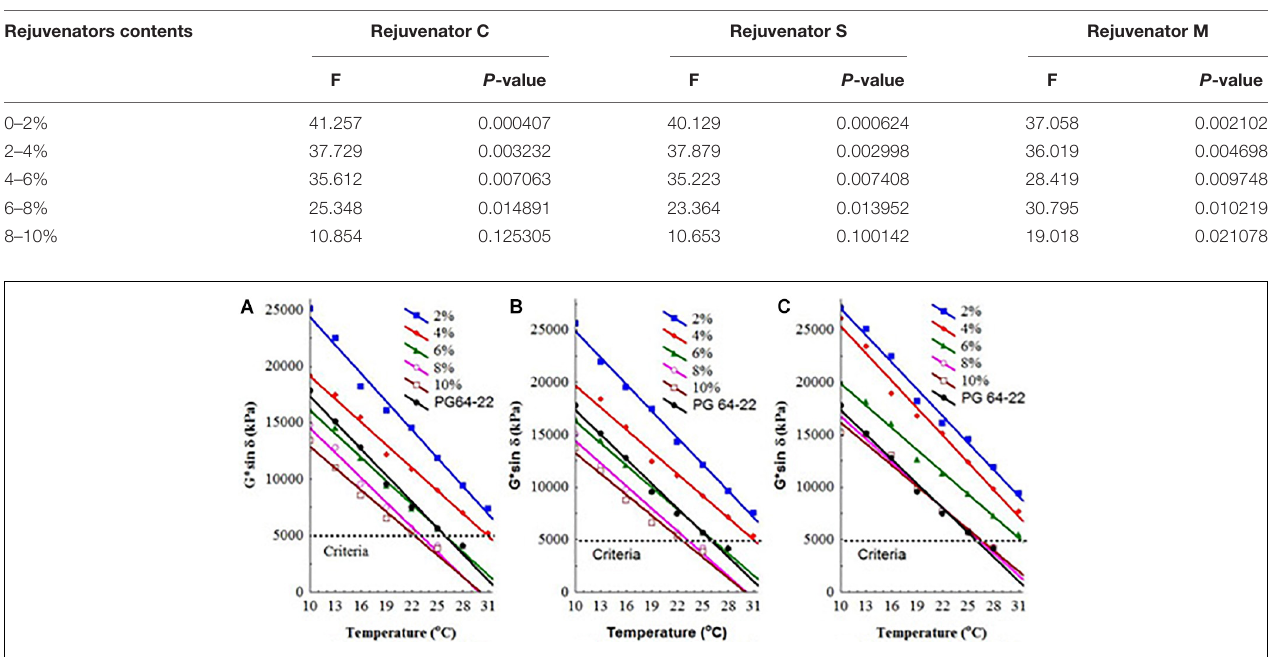
FIGURE 8 | Fatigue factors for the recovered bitumen with different contents of C, S, and M rejuvenators. (A) Rejuvenator C (based on corn oil). (B) Rejuvenator S (based on soybean oil). (C) Rejuvenator M (based on fuel oil).